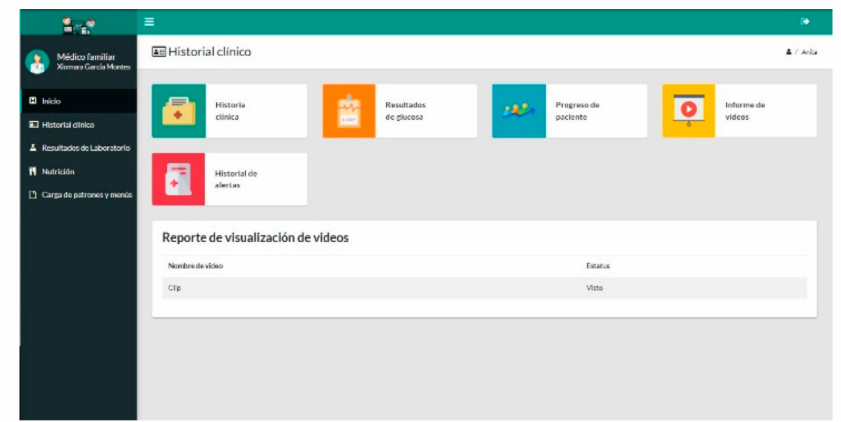
Figure 20. Physician application interface: Video consultation report for education and awareness of the disease.